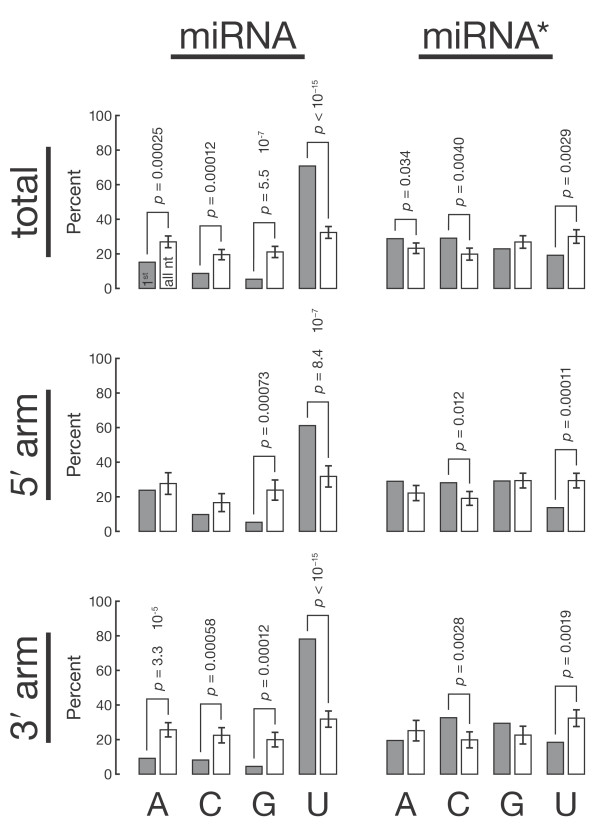
Fly miRNA tend to start with U. Each miRNA or miRNA* isoform derived from a common pre-miRNA was weighted according to its abundance in the pooled deep-sequencing libraries, and the sequence composition analyses for all small RNA from different pre-miRNA that were read at least 100 times in the pooled libraries were weighted equally. Gray, nucleotide frequency at position 1; white, 100 sets of nucleotides randomly selected from nt 1-18 of the miRNA and miRNA* species to assess the overall nucleotide composition of miRNA and miRNA*. Each random set had the same size as the corresponding set of miRNA or miRNA* 5′-nt. P values measure the probability of picking a random set from nt 1-18 with the same nucleotide frequency as the actual set of 5′-nt.